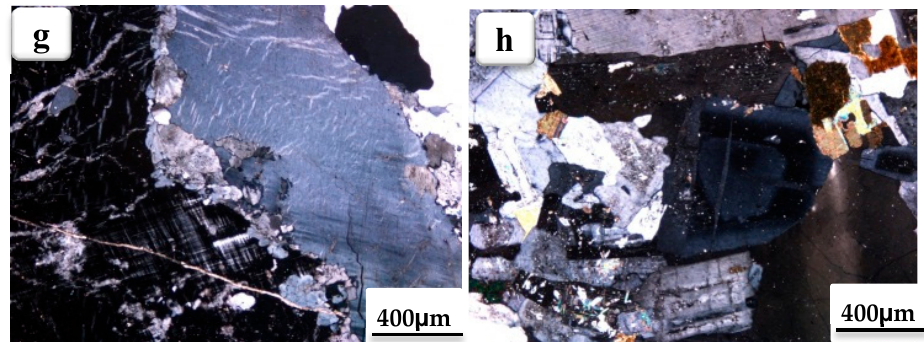
Figure 2. Photomicrographs for Aswan granite showing: ( a ) Subhedral crystal of perthite of tartan type, CN. ( b ) Second phase of biotite in perthite, CN. ( c ) Anhedral crystal of microcline perthite associating plagioclase, CN. ( d ) Well-formed crystal of zircon associating quartz and microcline perthite, CN. ( e ) Subhedral crystal of orthoclase perthite enclosing second phase of albite, CN. ( f ) Euhedral crystal of plagioclase with lamellar twining associating perthite, CN. ( g ) Anhedral crystals of plagioclase with vermicular of quartz (myrmikitic) on the border of string perthite, CN. ( h ) Zoned crystal of plagioclase associating albitic plagioclase, quartz and biotite, CN. Plagioclase is represented by subhedral to euhedral prismatic crystals of variable sizes with distinct lamellar twinning (Figure 2f). Myrmekite texture is developed at the margins of plagioclase and microcline (Figure 2g). Some plagioclase crystals are oscillatory zoned (Figure 2h). It is coarse to very coarse grains which are digested and mantled by perthite (Figure 3a), referring to the mixing magma. Epidotization and muscovitization are the main alteration product of plagioclase (Figure 3b,c). The plagioclase exsolution lamellae are large enough to exhibit the characteristic polysynthetic twinning pattern (parallel stripes). In contrast, the K-feldspar host displays splendid “tartan” or “cross-hatched” twinning.